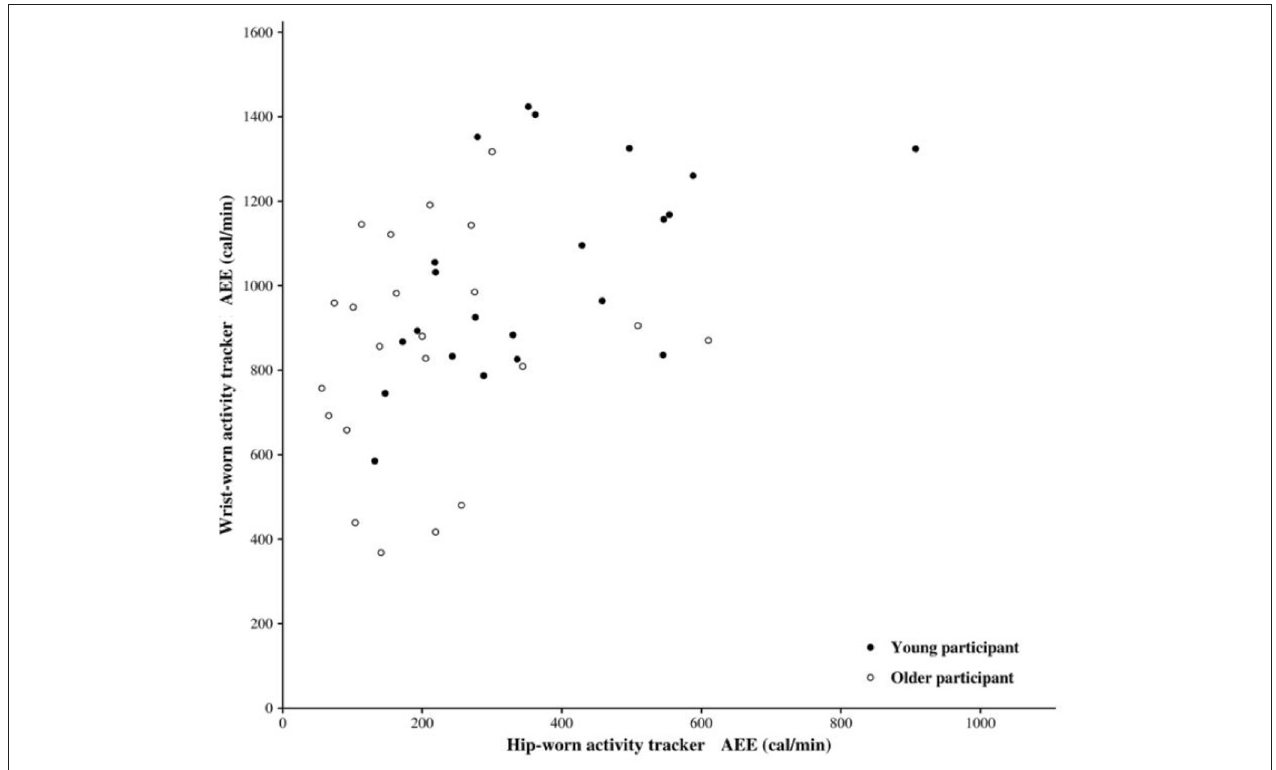
FIGURE 2 | Association between active energy expenditure (AEE) measured by hip-worn and wrist-worn activity tracker.